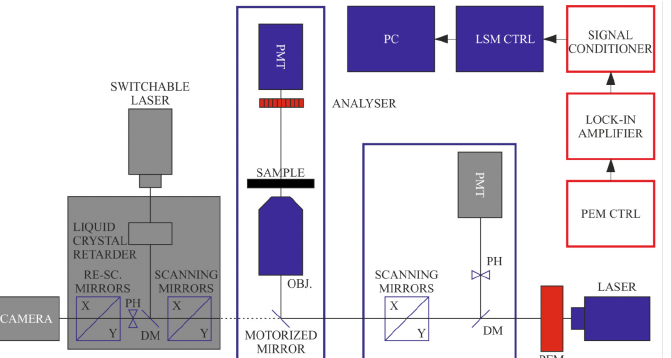
Figure 3. Schematics of LB imaging using the DP-LSM setup, using the transmission detector, in this case, in non-confocal regime, and an analyser applied in front of the detector. (Components inactive in this configuration are displayed in